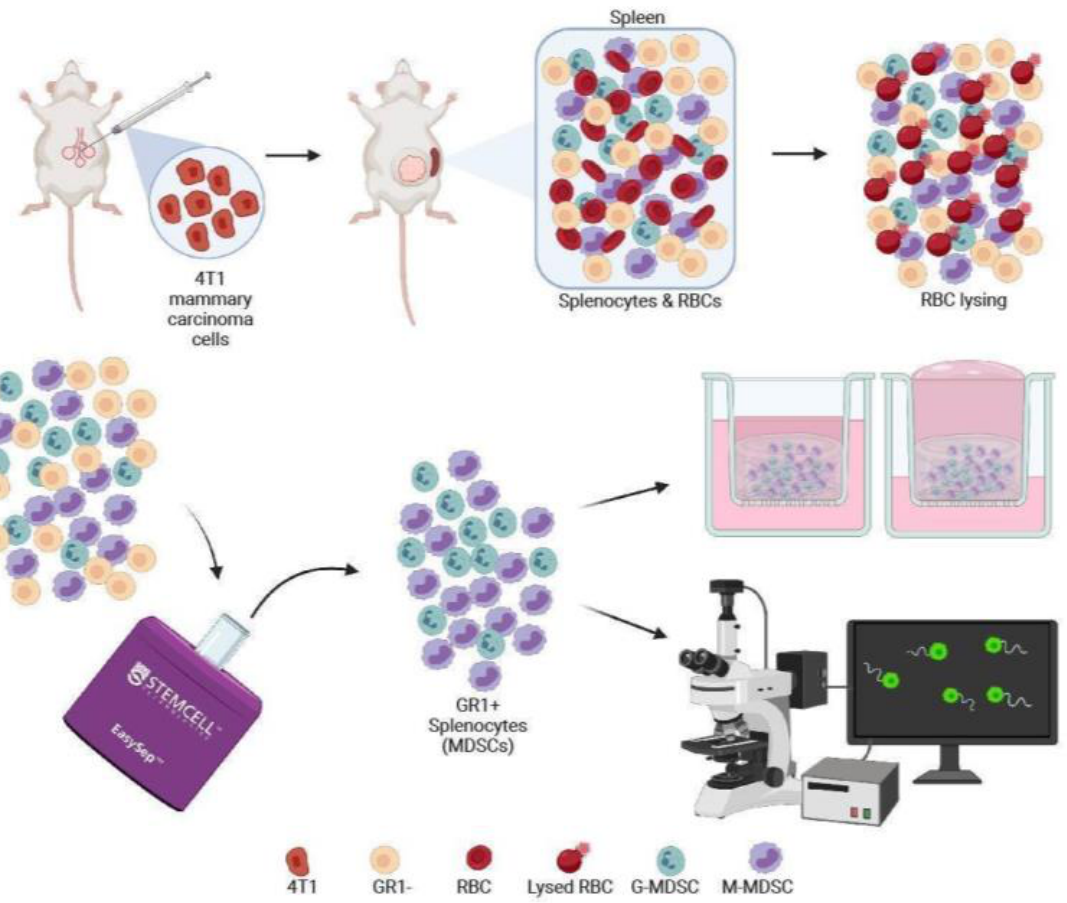
Figure 1. Workflow schematic for harvesting MDSCs for analysis of invasion and motility. 4T1 mu- rine mammary carcinoma cells were injected into a female Balb/c mouse. When tumor size was sufficient, the spleen was harvested and digested for splenocyte isolation and EasySep TM immuno-